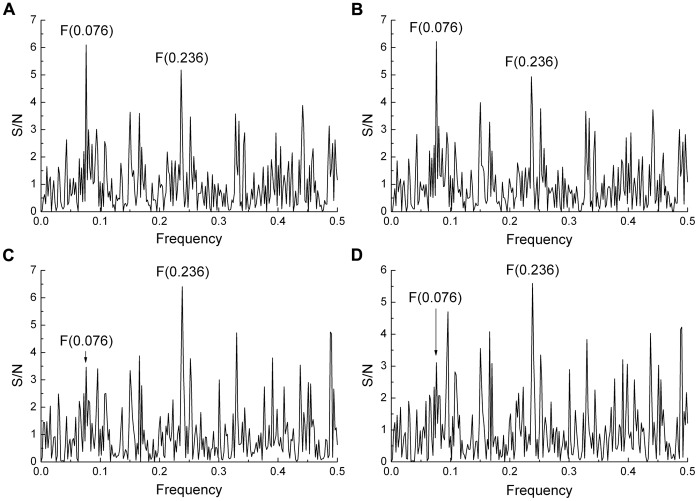
Comparison of informational spectra of H5N1-HPAIV from poultry and humans isolated 2006–2010.(a) A/chicken/Egypt/R1/2006, (b) A/Egypt/2763-NAMRU3/2006, (c) A/chicken/Egypt/1029/2010, (d) A/Egypt/N04434/2010.